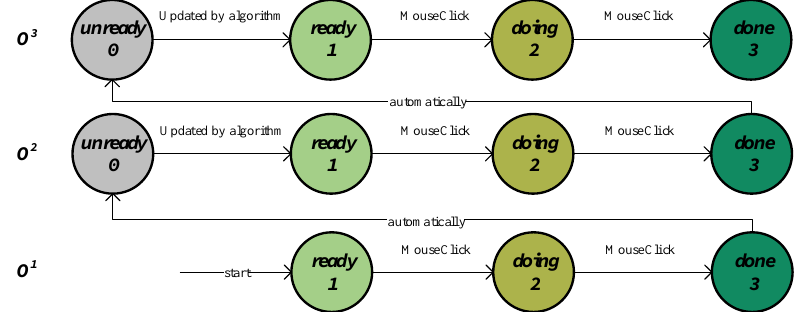
Figure 12. Deterministic finite state automata for the simulation of multi-operation collaboration.